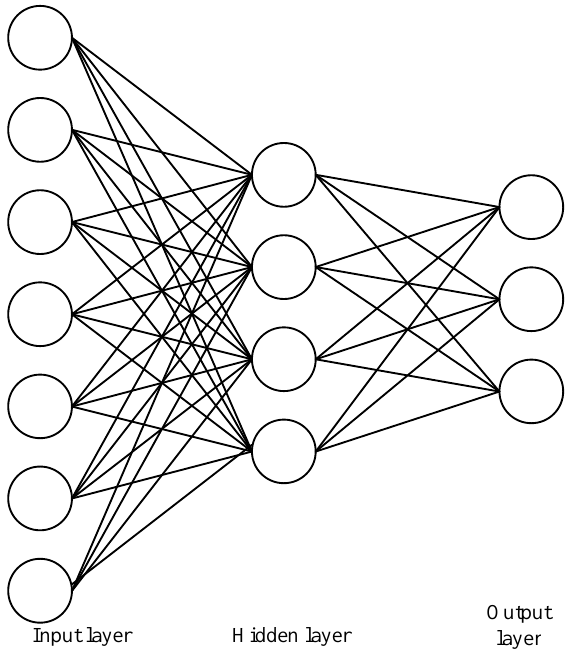
Figure 4 Structure of the ANN brand choice